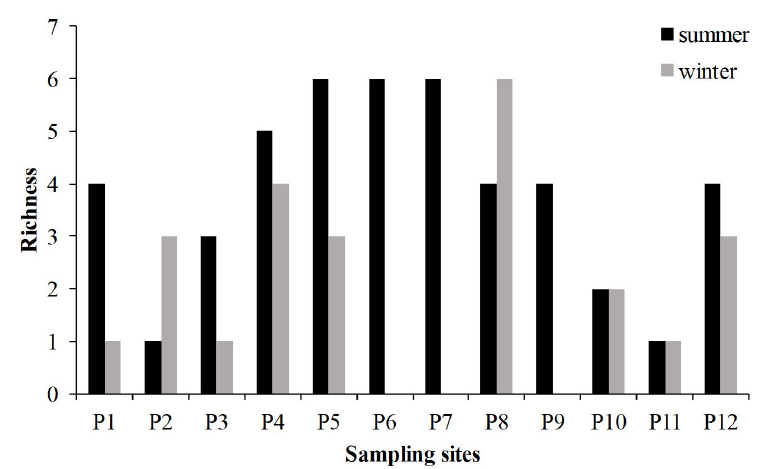
Figure 4. Macrophyte species richness in different sampling sites of the Itupararanga Reservoir during two periods (summer and